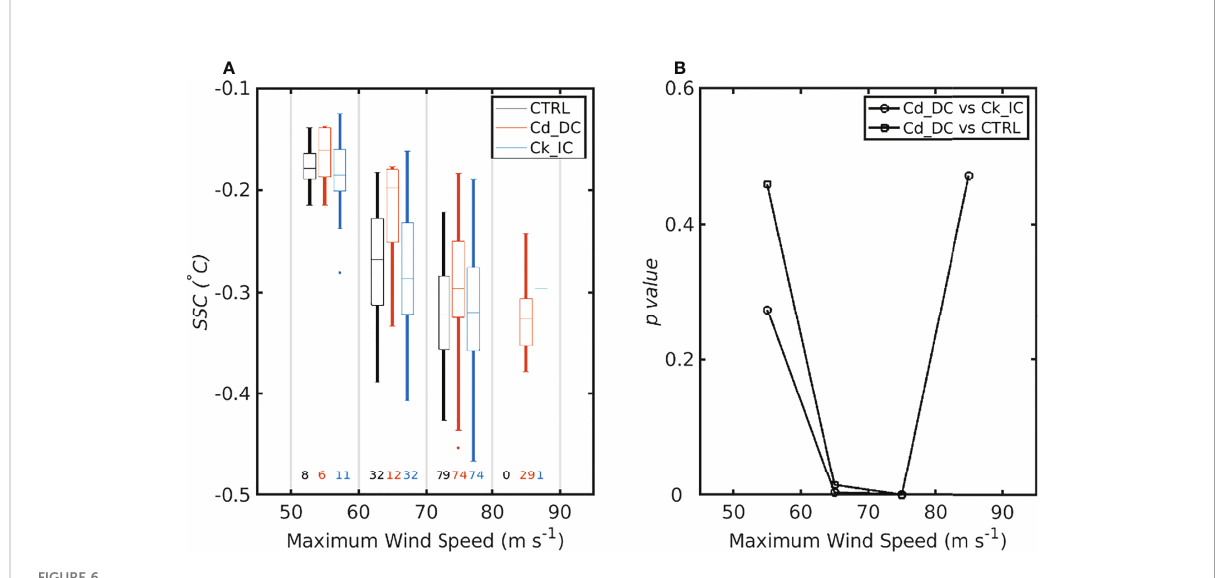
FIGURE 6 (A) Boxplots for sea surface cooling (°C) as a function of MWS at each 10-m s − 1 interval. The lines denote the median values, and the box covers the 25%-75% quantile. The bars show the minimum and maximum values, and the points show the outliers. Colors indicate results for CTRL (black), Cd_DC (red) and Ck_IC (blue). The numbers above the x-axis denote the assigned TC case number for each experiment. (B) The distribution of p -value for the SSC differences between Cd_DC and Ck_IC (solid open circle) and between Cd_DC and CTRL (solid open square). The p -values are based on Student